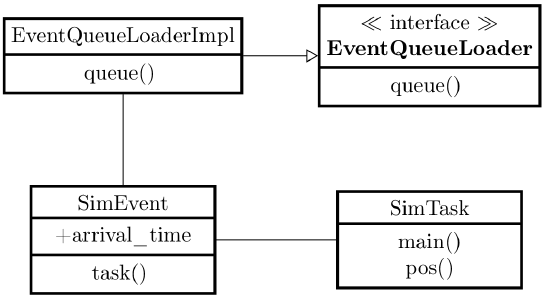
Figure 7. Simulator structure